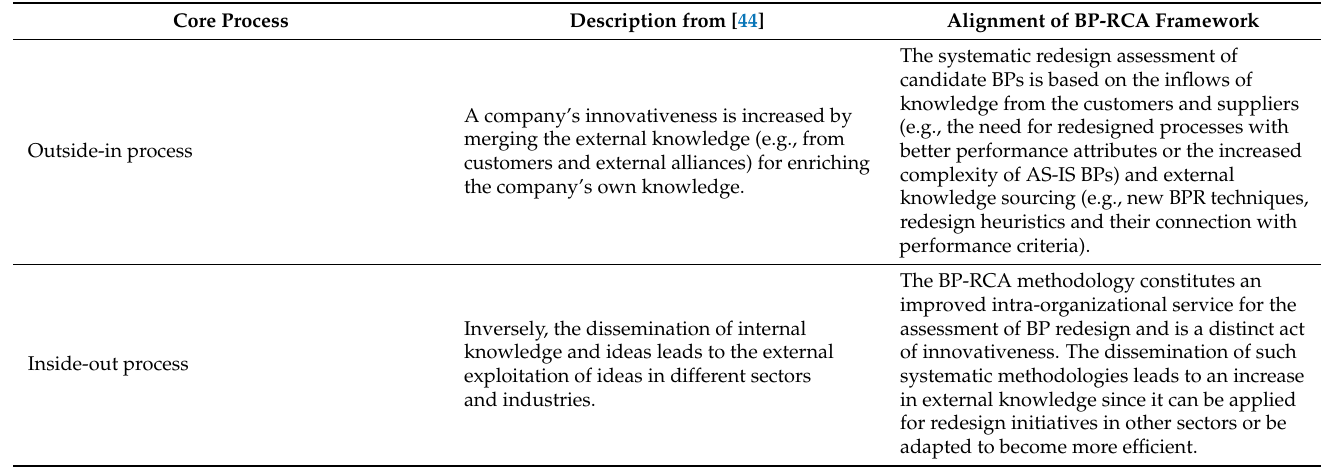
Table 1. Alignment of BP-RCA framework with open